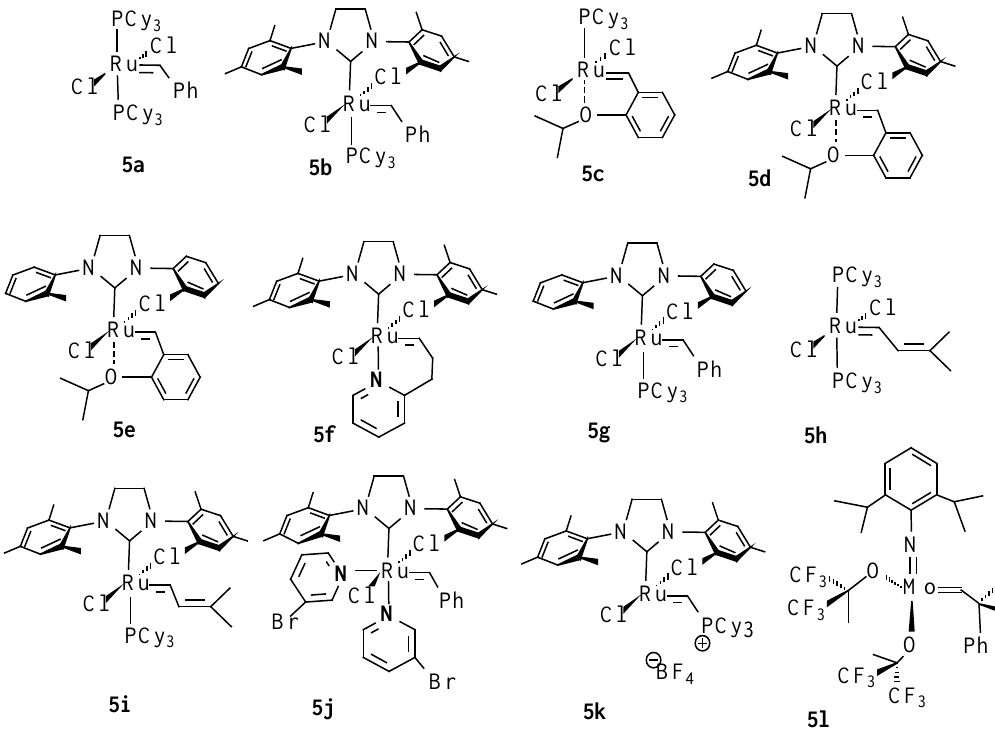
Figure 3. Some commercially available Ru and Mo based metathesis catalysts (Cy = cyclohexyl).